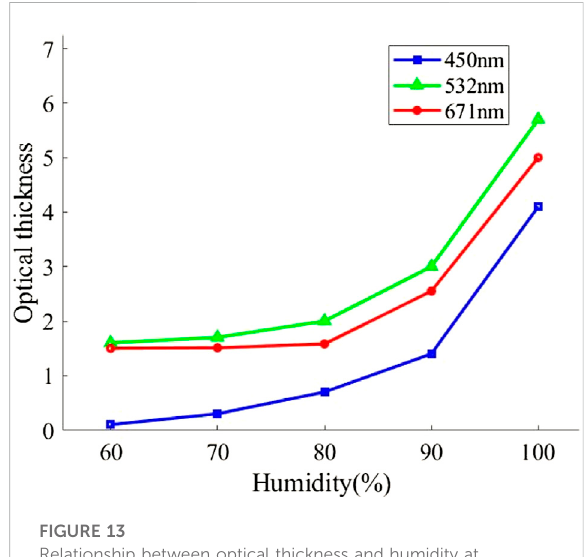
FIGURE 13 Relationship between optical thickness and humidity at various